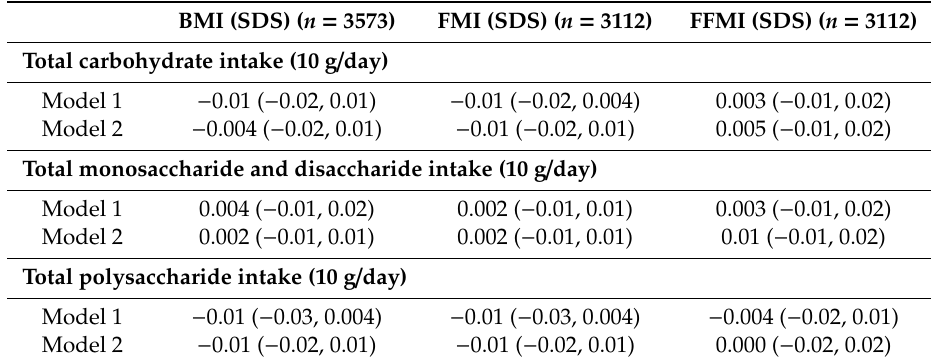
Table 2. Associations of carbohydrate intake at age 1 year with body composition up to age 10